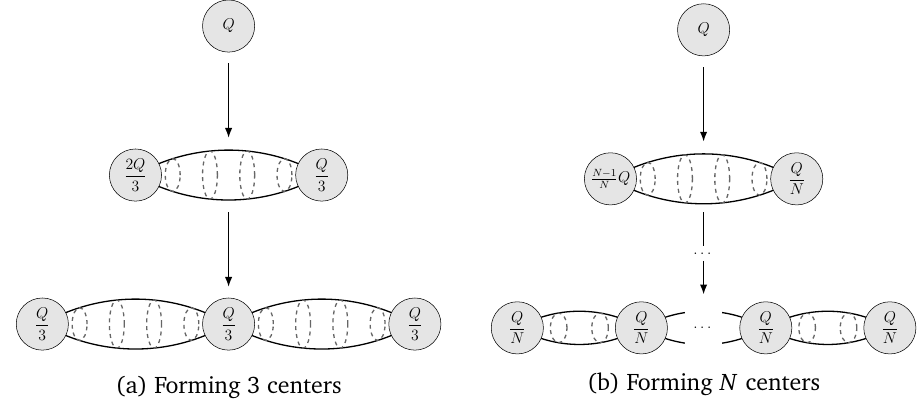
Figure 1: Two sample formation paths to tunnel into a multi-centered